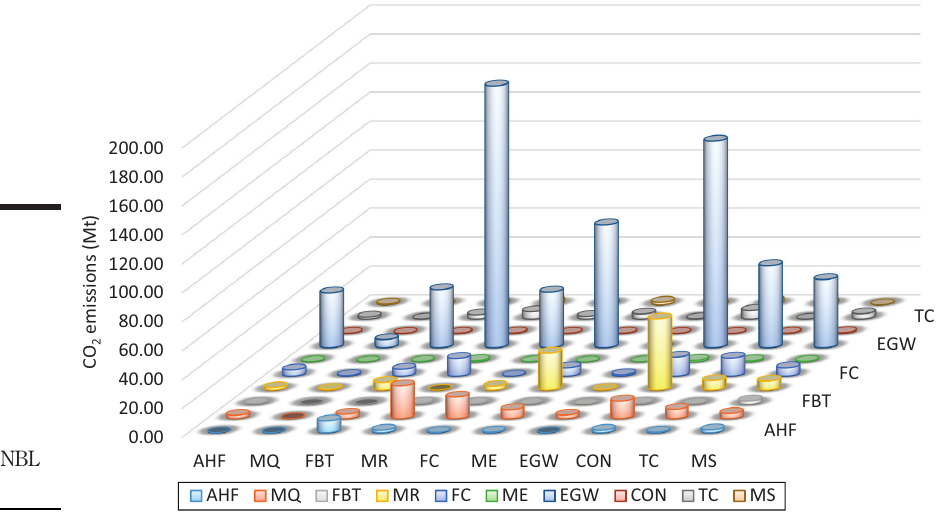
Figure 5. Decomposed ENBL and